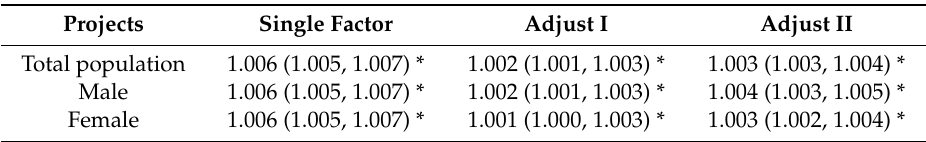
Table 2. The relationship between the PM 2.5 concentration and the total number of deaths from circulatory diseases and gender di ff erences.